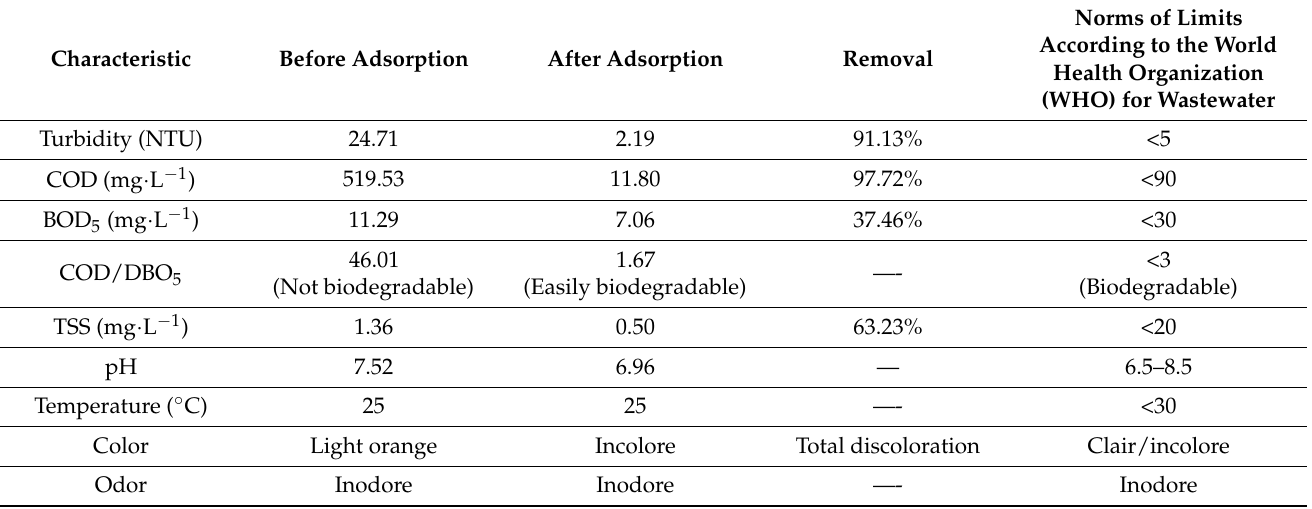
Table 6. Characteristics of textile wastewater before and after adsorption on MO C-ZnCl